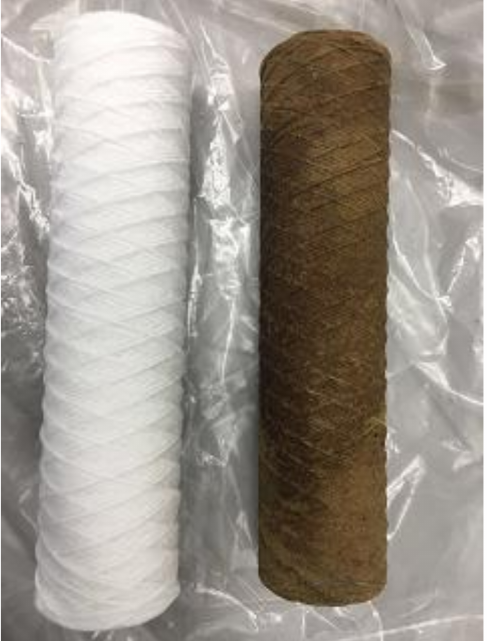
Figure 5. An example of a virgin prefilter ( left ) and a fouled prefilter ( right ).